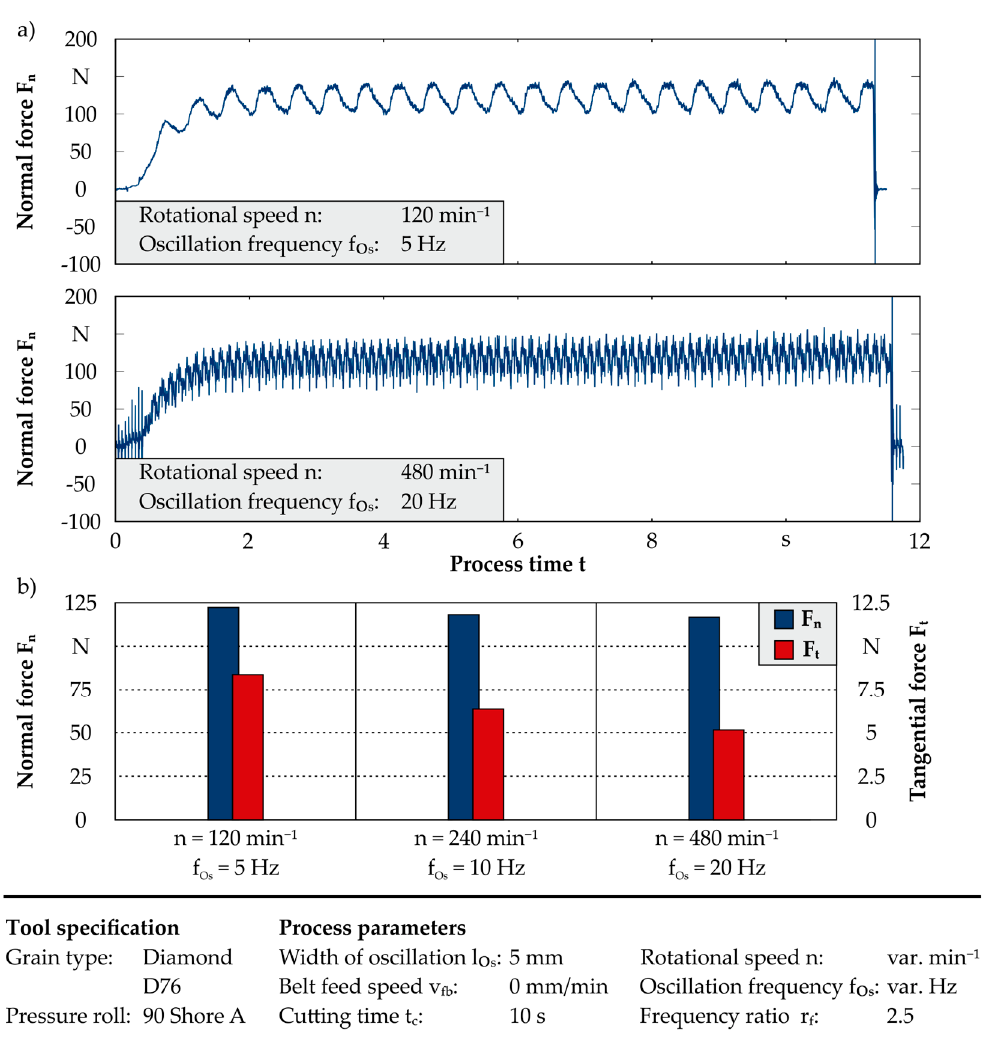
Figure 4. Force analysis for varying cuttings speed. ( a ) Force paths of the normal force F n ; ( b ) Mean values of the normal force F n and the tangential force F t .